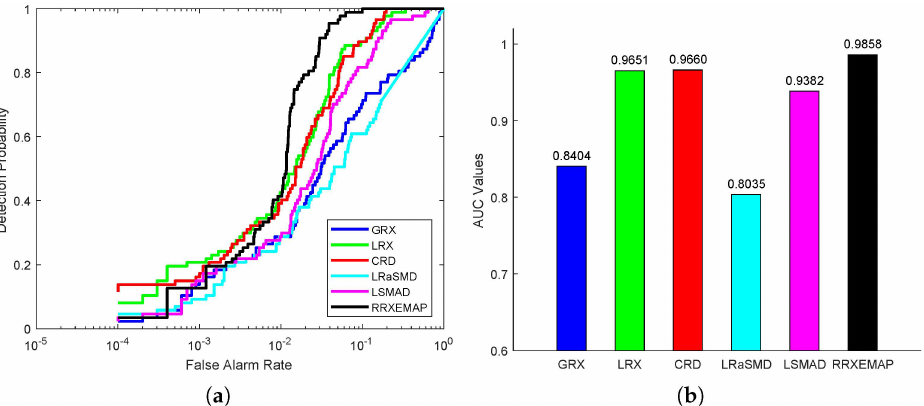
Figure 13. Detection accuracy evaluation for the abu-airport-2 dataset. ( a ) ROC curves. ( b ) AUC